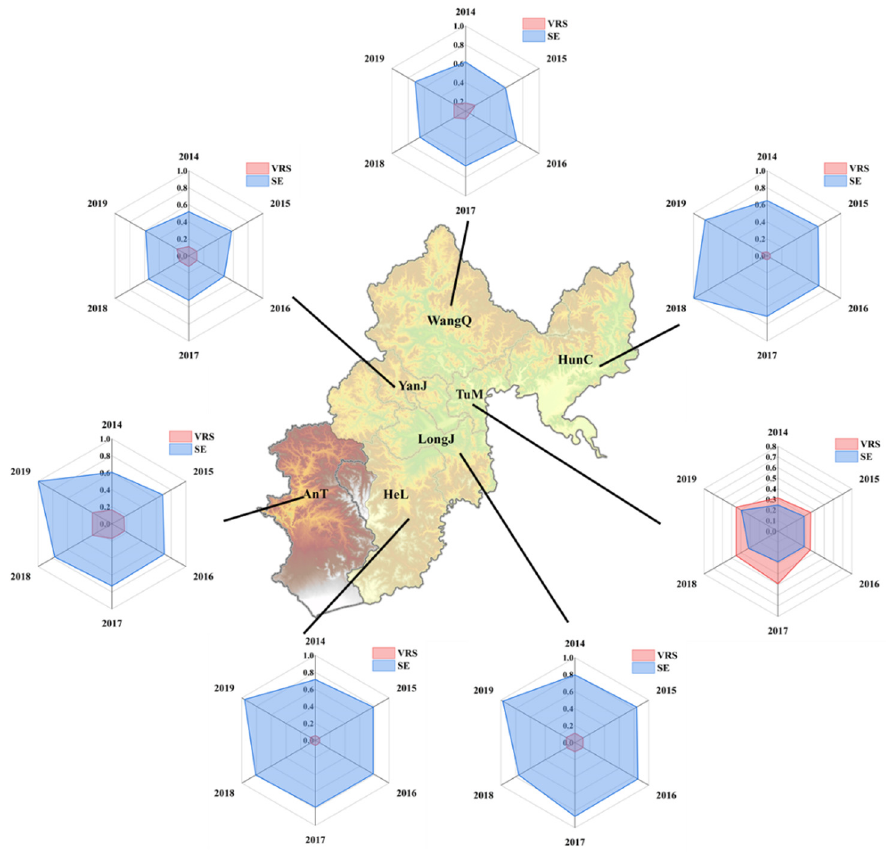
Figure 10. The result of TE and SE for agricultural water from 2014 to 2019.